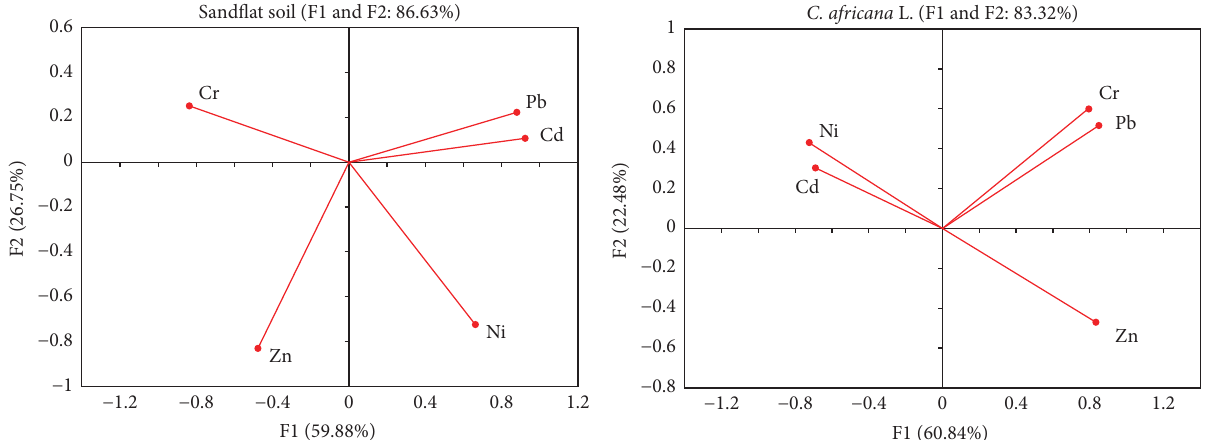
Figure 4: Factor loadings of principal components 1 and 2 for trace metals concentration in sandflat and C. africana L. samples showing the total variance explained by each